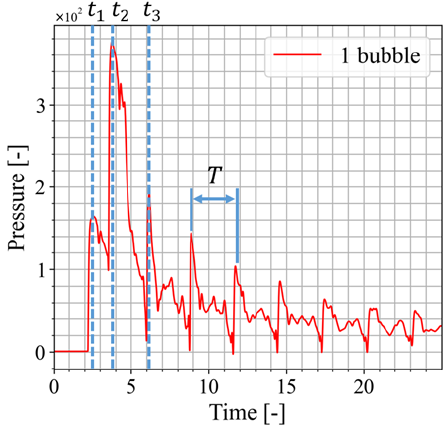
0.9, ( c ) t = 1.8, ( d ) t = 3.3, ( e ) t = 4.5, and ( f ) t = 5.4; numerical schlieren at the upper side and pressure